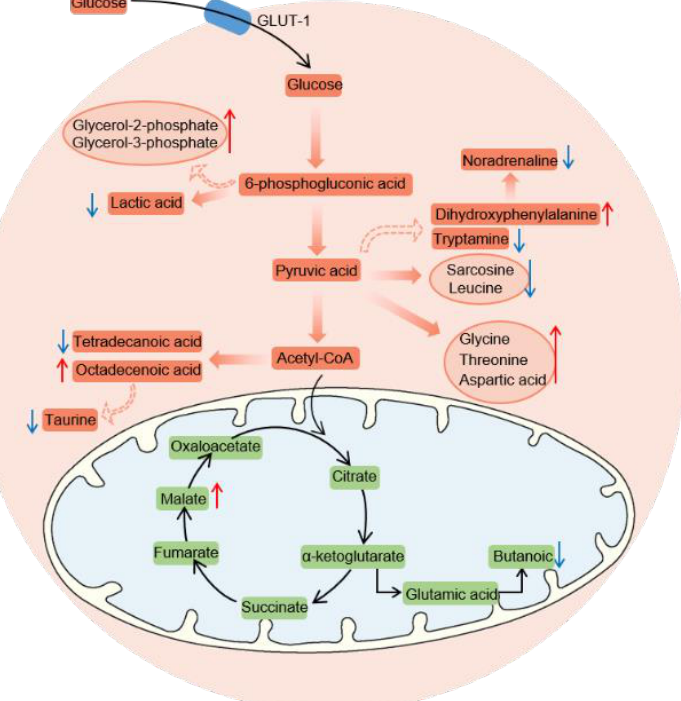
Figure 4. ATZ exposure leads to changes in glucose, lipid and amino acid related metabolites. Metabolites that changed significantly in the ATZ treatment group were indicated by different colored arrows. Red arrows indicate increased metabolite levels and blue arrows indicate decreased metabolite levels.